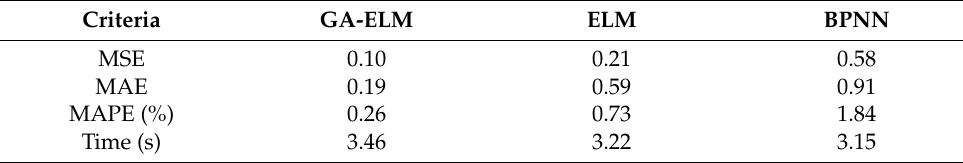
Table 2. Statistical indicators of different intelligent algorithms. Criteria GA-ELM